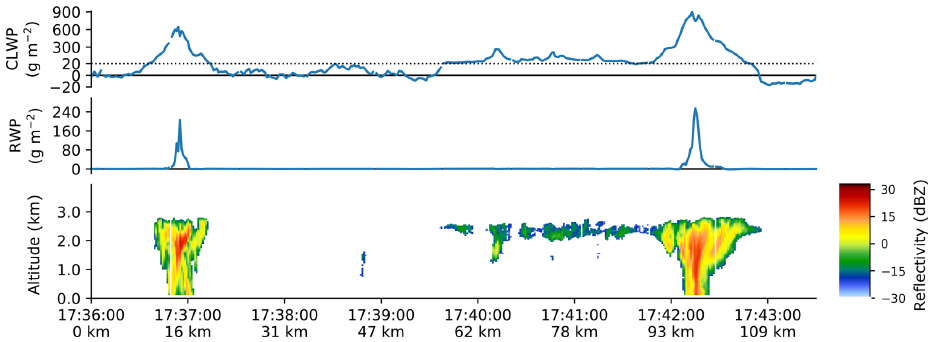
Figure 3. Example of retrieved quantities from active and passive HAMP measurements from NARVAL1 research flight 8 on 20 December 2013. Top: cloud liquid water path; middle: rain water path; bottom: radar reflectivity. Note the scale change in the top panel at 20gm − 2 . For more information on the retrieval methods, see Jacob et al. (2019). (Figure adapted from Jacob et al.,